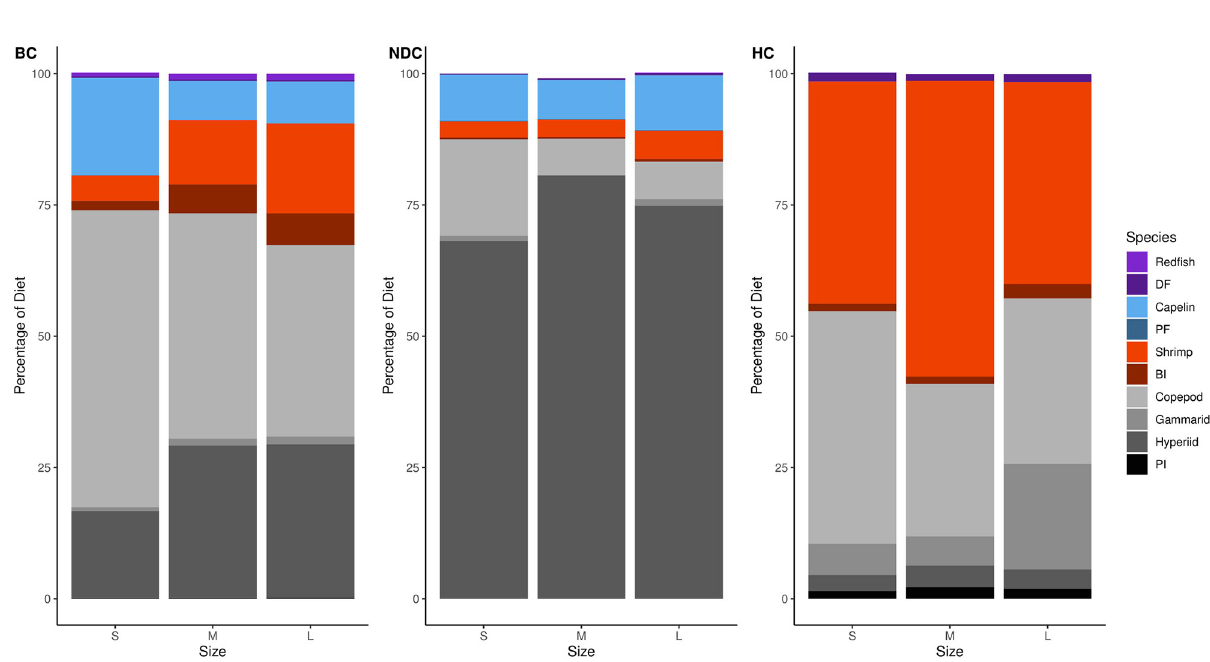
Fig 5. Greenland halibut diet composition percentages as determined from isotope mixing models. This figure is divided by predator size category (S for small, M for medium, L for large, see Table 2) and region (BC for Bonavista Corridor, NDC for Notre Dame Channel, HC for Hawke Channel). Prey taxa abbreviations are defined in Table